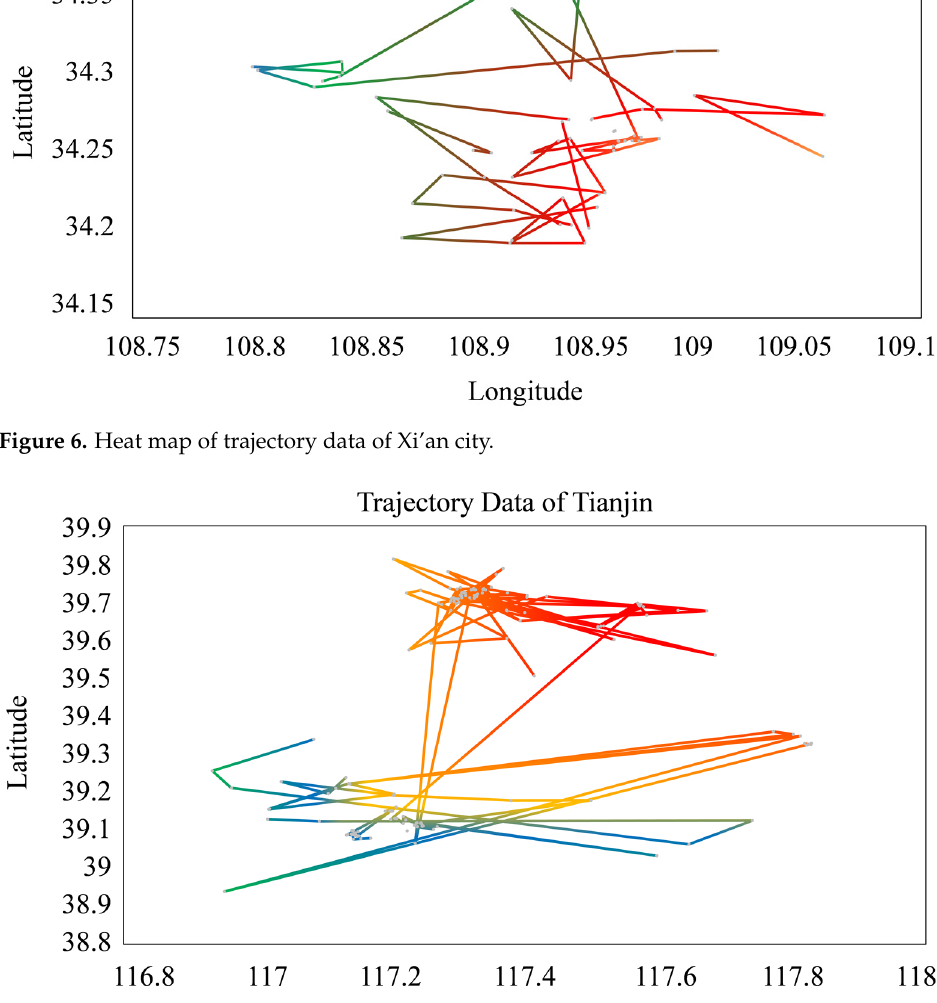
Figure 8. Heat map of trajectory data of each city.